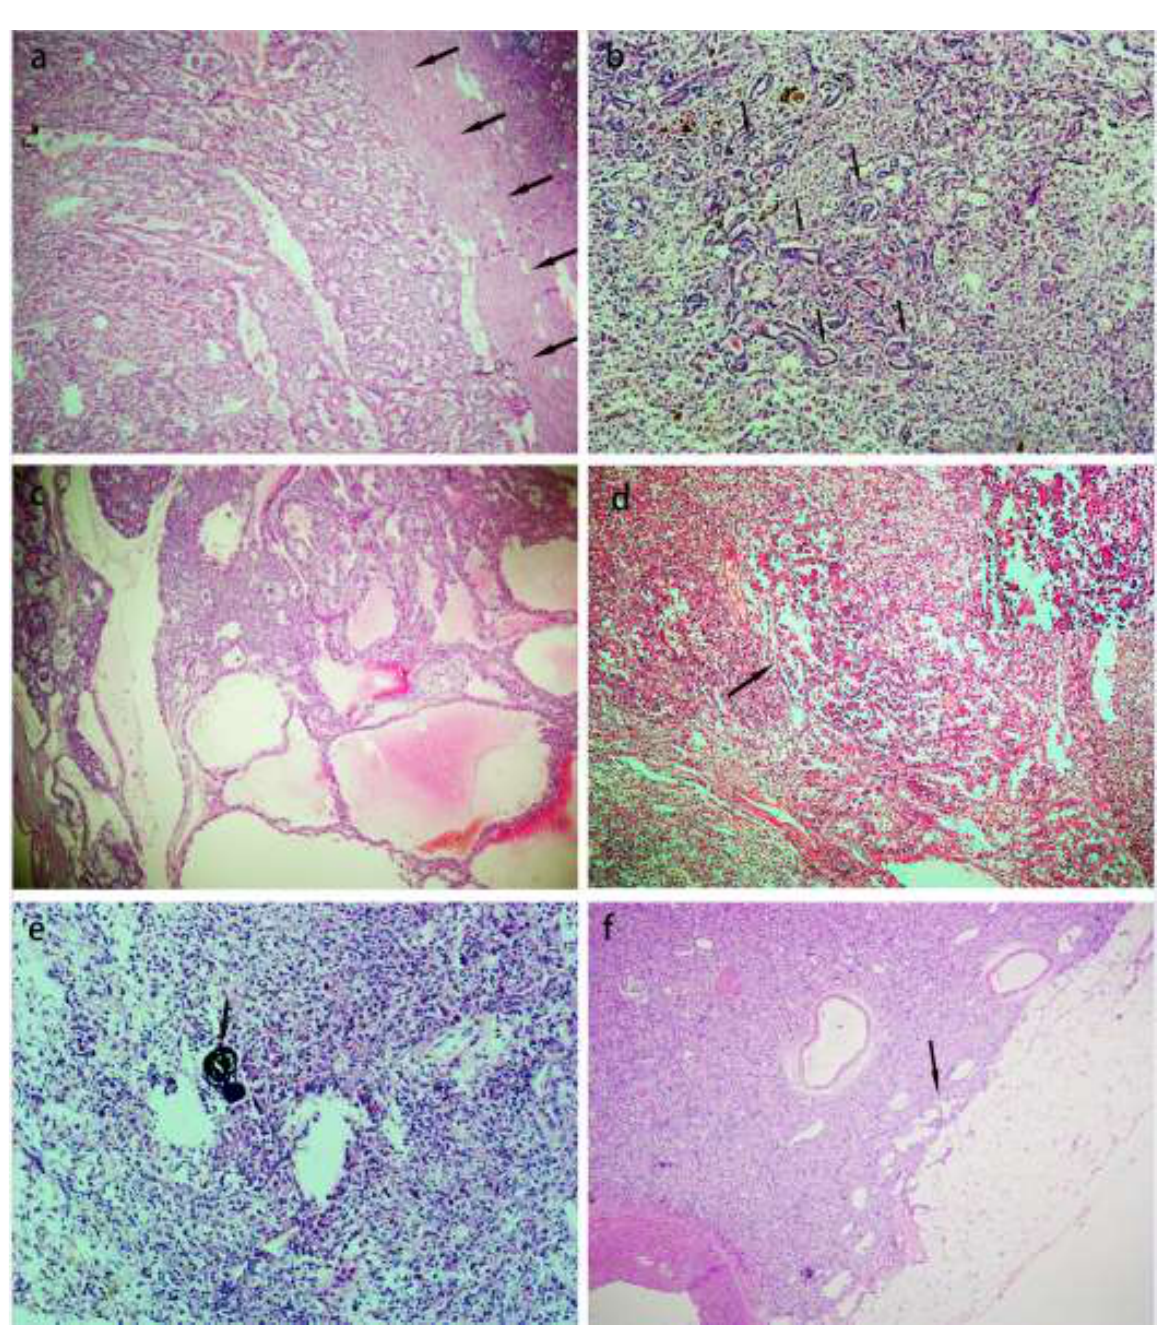
Figure 2. Architectural features of the TFEB rearranged RCC. ( a ). On low power, the tumors were most well-circumscribed and presented a thick fibrous pseudocapsule (arrowheads). ( b ). Entrapped non-neoplastic renal tubules could be presented in the tumors (arrowheads). ( c ). The tumor cells demonstrated a solid sheet, tubular growth pattern with local cystic changes. ( d ). A biphasic “rosette- like” pattern was seen in half of the tumors (arrowheads). ( e ). Psammomatous calcifications were seen in a few cases (arrowheads). ( f ). On low power, the tumor infiltrated adipose tissue in renal sinus (arrowheads).